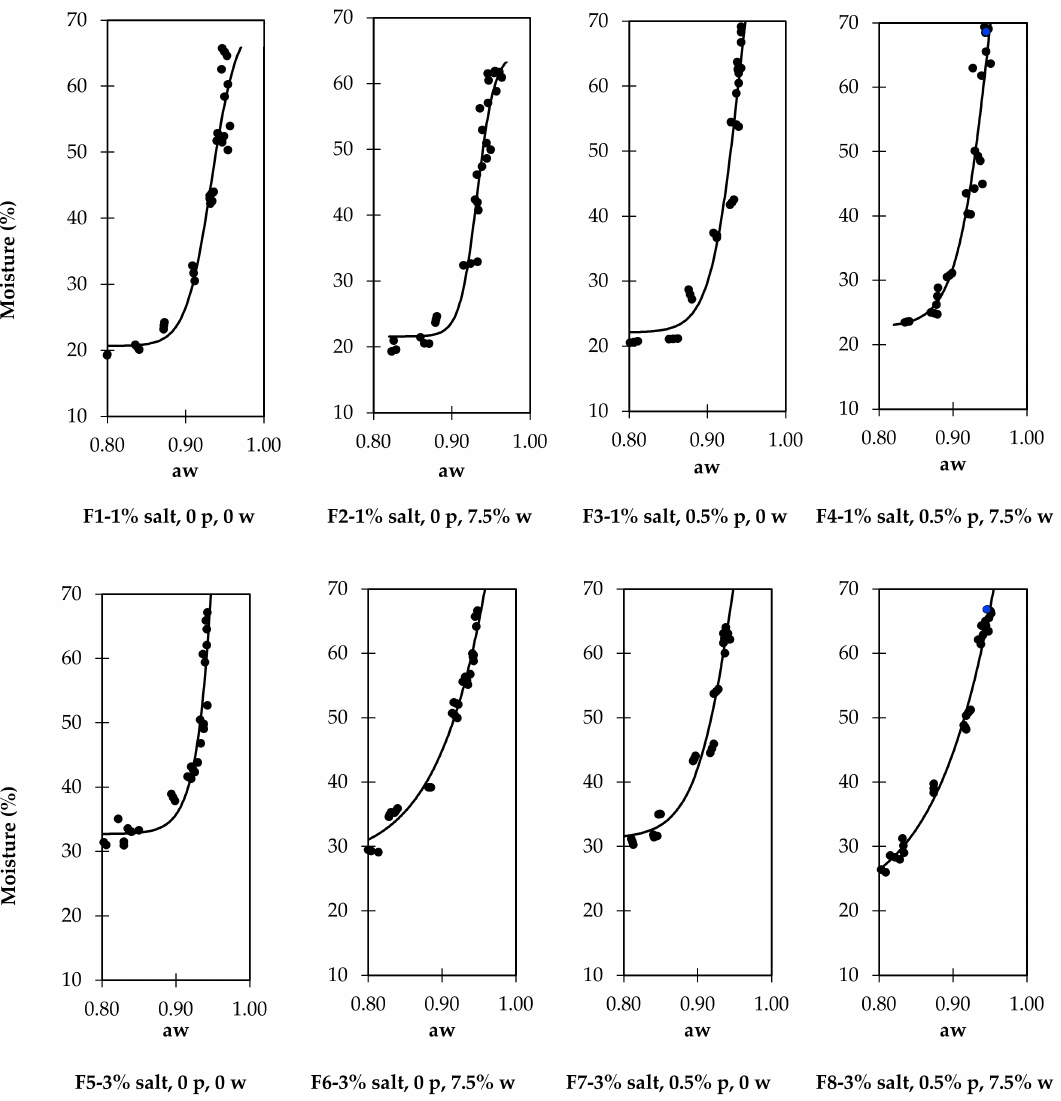
Figure 2. Relation between the water activity (aw) and moisture in cured sausages with different formulations. p—phosphate;